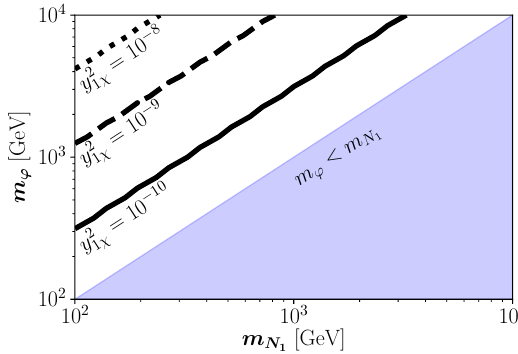
Figure 5 . Fermionic Dark Matter Scenario. E(cid:11)ective coupling y 2 observed relic abundance via the FIMP mechanism, assuming m ’